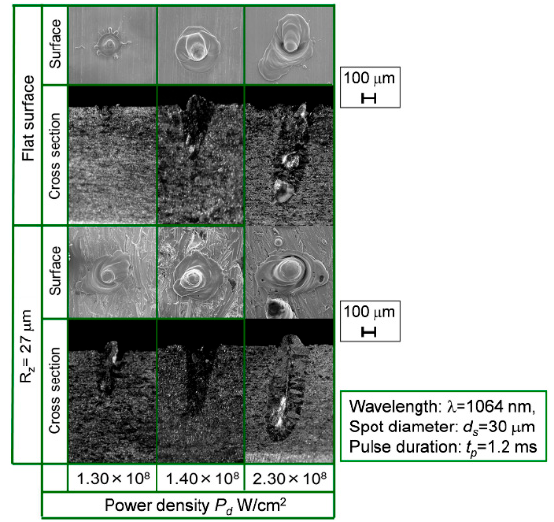
Figure 12. Observed surfaces and cross-sections for different power densities in the case of flat surface and R z = 27 μ m.